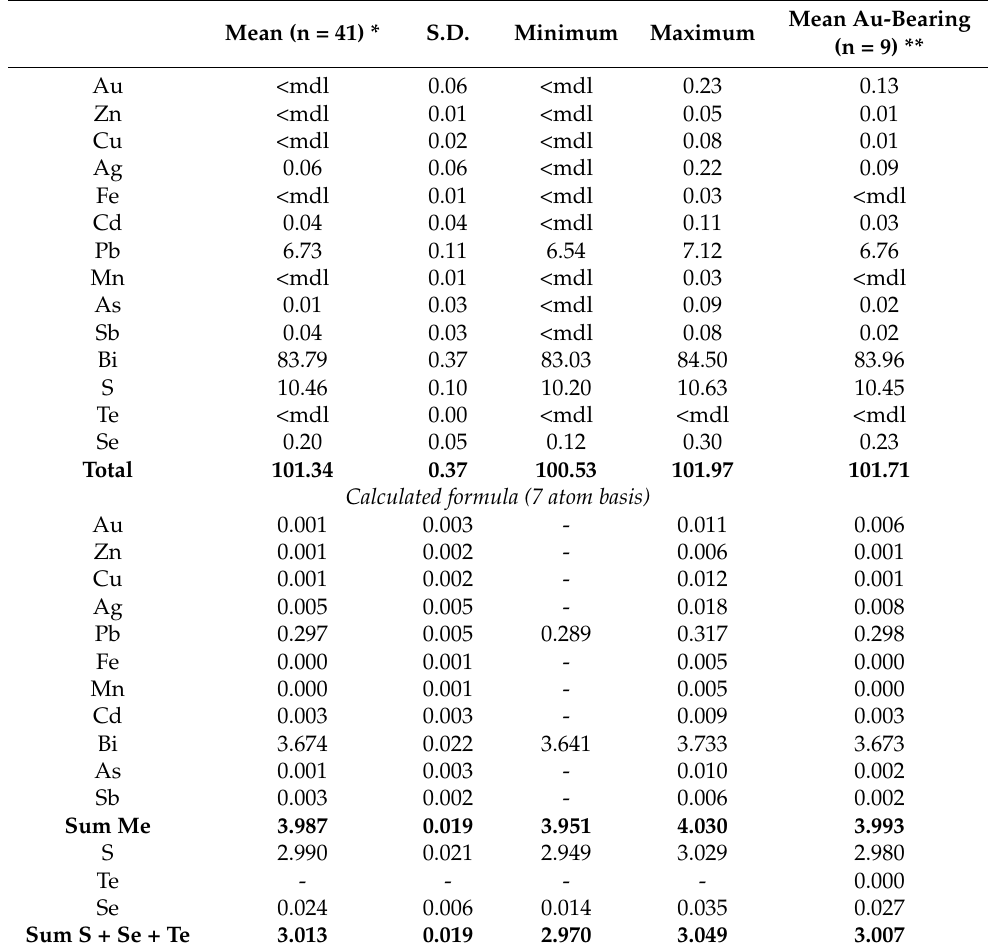
Table 3. Electron probe microanalysis data for ikunolite (wt.%).